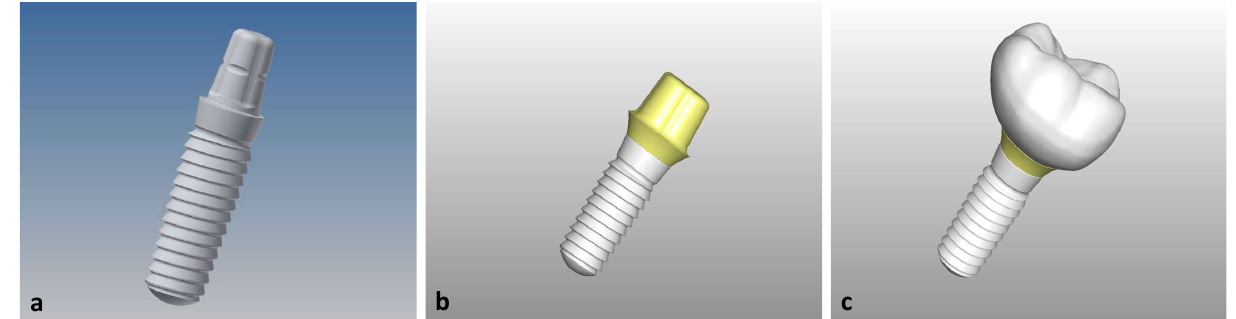
Figure 1. ( a ) Implant after manual entry of the geometries in the software Inventor; ( b ) imported mesostructure in the Freeform software on the before constructed implant; ( c ) Representation of the suprastructure constructed on the mesostructure.